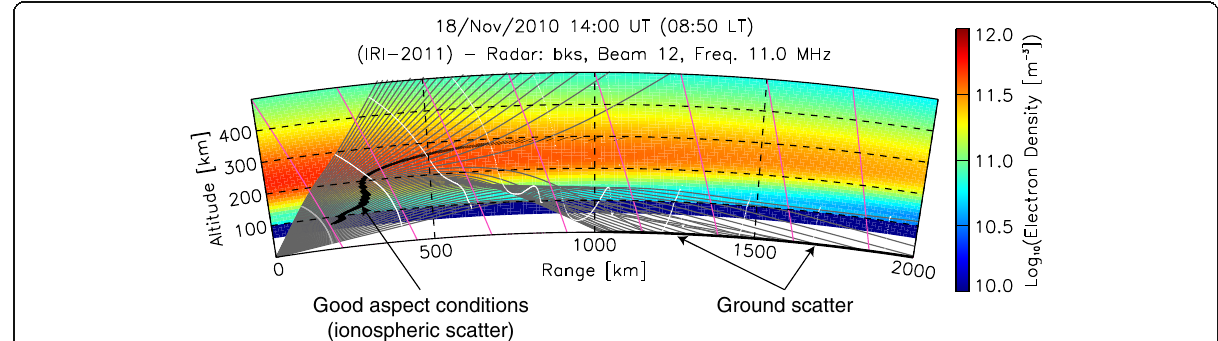
Fig. 3 Ray-tracing results for 11 MHz transmissions on beam 12 of the Blackstone radar propagating through the predicted IRI-2011 ionosphere on 18 November 2010 at 14:00 UT (see text for details). Reproduced from Fig. 3 of de Larquier et al. (2013)